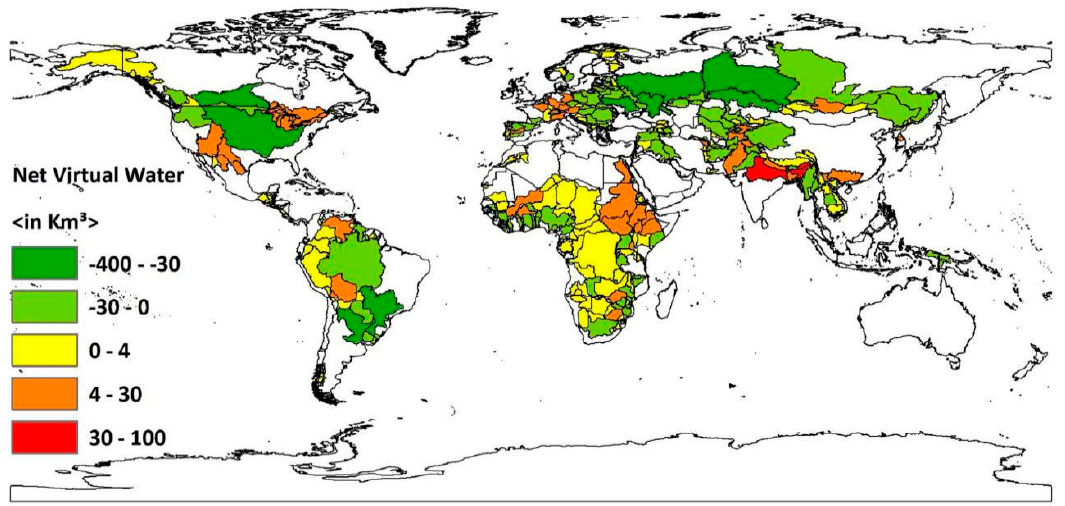
Figure 2. Net virtual water balance for global transboundary river basins’ country-basin units. Period: 1996–2005. This map was generated with ArcGIS 10.2 for desktop from Environmental Systems Research Institute (ESRI), Redlands, CA, USA [28].